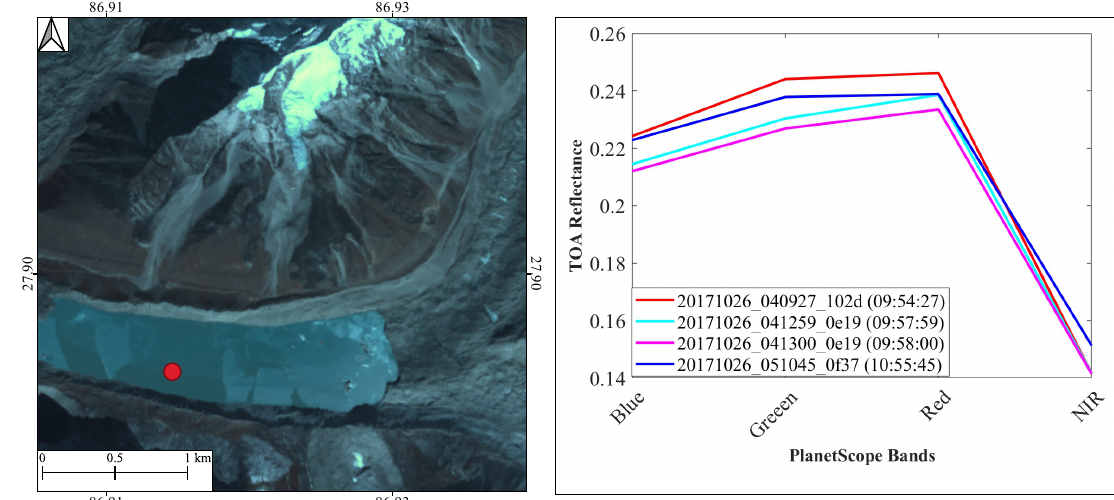
Figure 1. Top of atmosphere reflectance of four different PlanetScope scenes acquired over lake Imja Tsho near Mount Everest. The Top of Atmosphere (TOA) reflectance is computed by multiplying the coefficients given in the metadata file with the 16-bit radiance value. The atmospheric effects are not compensated in TOA reflectance. The scene id shows the date and time (in UTC) of acquisition along with the satellite Id. Local time is given along with scene id. The reflectance values are calculated for 5 × 5 pixels neighborhood corresponding to the location in the lake. The surface reflectance product is not used due to the known issues in computing the surface reflectance of the low surface reflecting water